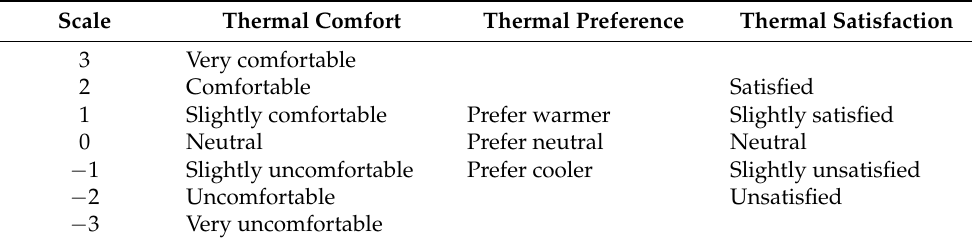
Table 2. Scale of thermal comfort, preference, and